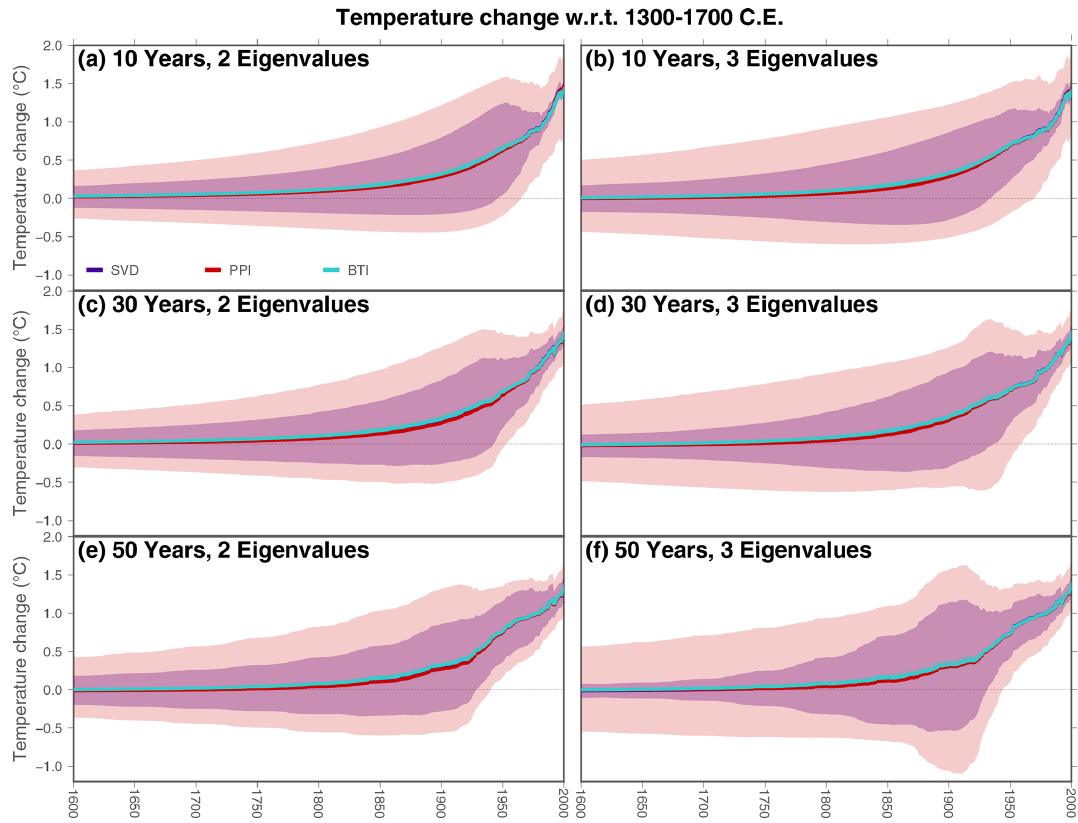
Figure 5. Global averaged ground surface temperature histories from Xibalbá profiles using different step lengths for retrieving the surface signal (rows) and retaining different numbers of eigenvalues (columns). Colors indicate the method employed for the estimates: SVD (purple), PPI (red), and BTI (light blue). BTI results are derived using a Sampling ensemble of 1079 members and a Bootstrapping ensemble of 1000 members. Shadows indicate the uncertainty range for each method. Note that the uncertainty in BTI results is represented, although difficult to visualize due to its small